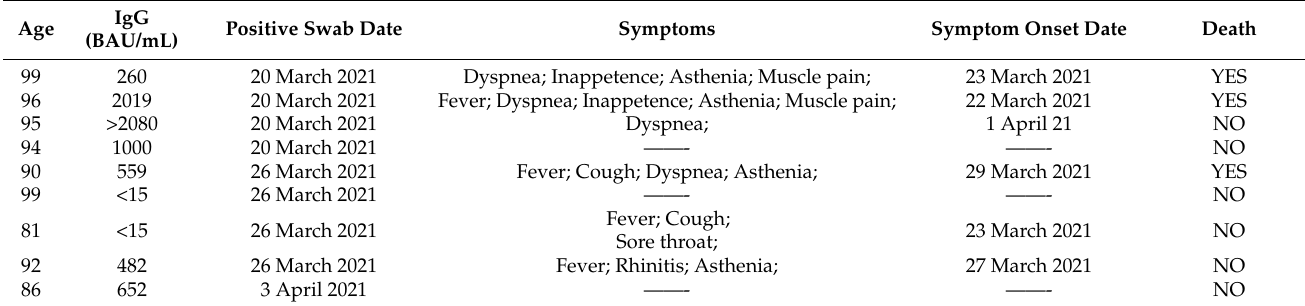
Table 2. Clinical and serological conditions of the 9 positive vaccinated guests.